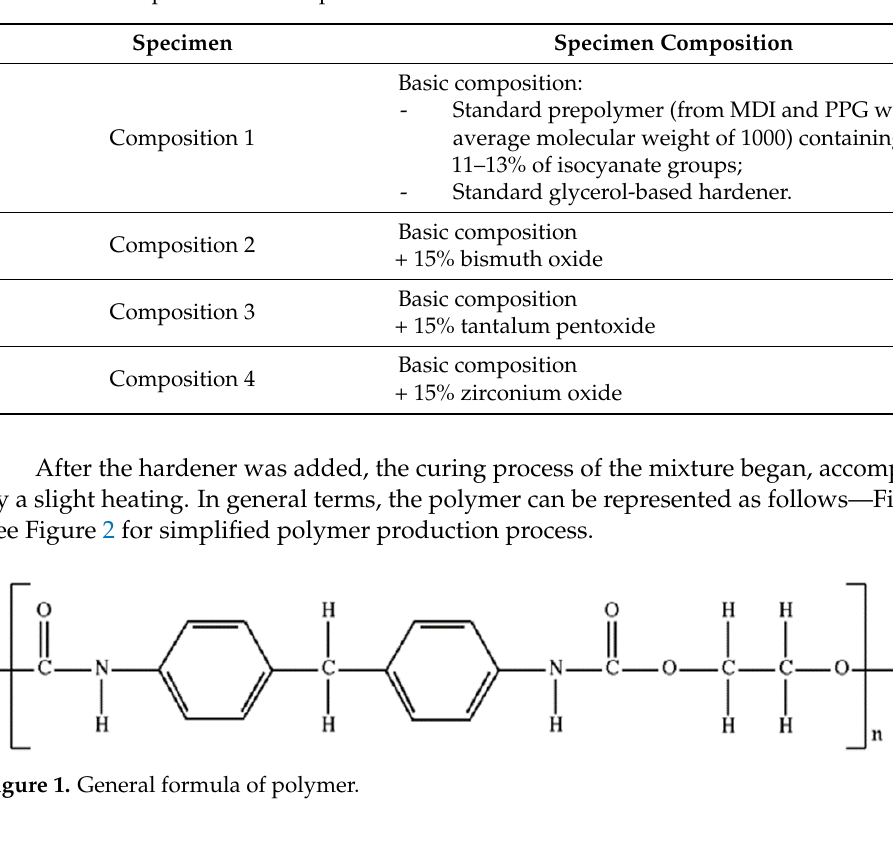
Figure 2. Simplified general formula for polymer production. After complete curing, 24 h later, the materials were cut into specimens of the desired shape and size for the study. The specimens of all 4 compositions were sterile yellowish tablets (Figure 3). Each series of 12 specimens was individually labeled and each specimen was individually packaged. The specimens were approximately 10 mm dia × 2 mm thick. Cross sections of the specimens of the materials showed chaotically located holes of dif- ferent diameters (pores formed during the polymerization reaction); microscopic studies indicated different shapes and sizes of holes distributed across the entire surfaces of the specimens. Figure 3. Representative photograph of one of the studied specimens — appearance. To assess the biological characteristics of the presented materials and the possibility of their subsequent application in biomedicine, the level of cytotoxicity and any changes of test culture cells during cultivation on the specimens were evaluated. To assess the cytotoxicity, an MTT (3-[4,5-dimethylthiazol-2-yl]-2,5 diphenyl tetrazo- lium bromide) assay [46] was used to determine the estimated relative growth rates (RGRs) of the cells, as percentages based on a determination of the relative optical density (OD) levels. A plate reader was used to run the measurements and to evaluate them ac- cording to a ranking scale [47] for each material.